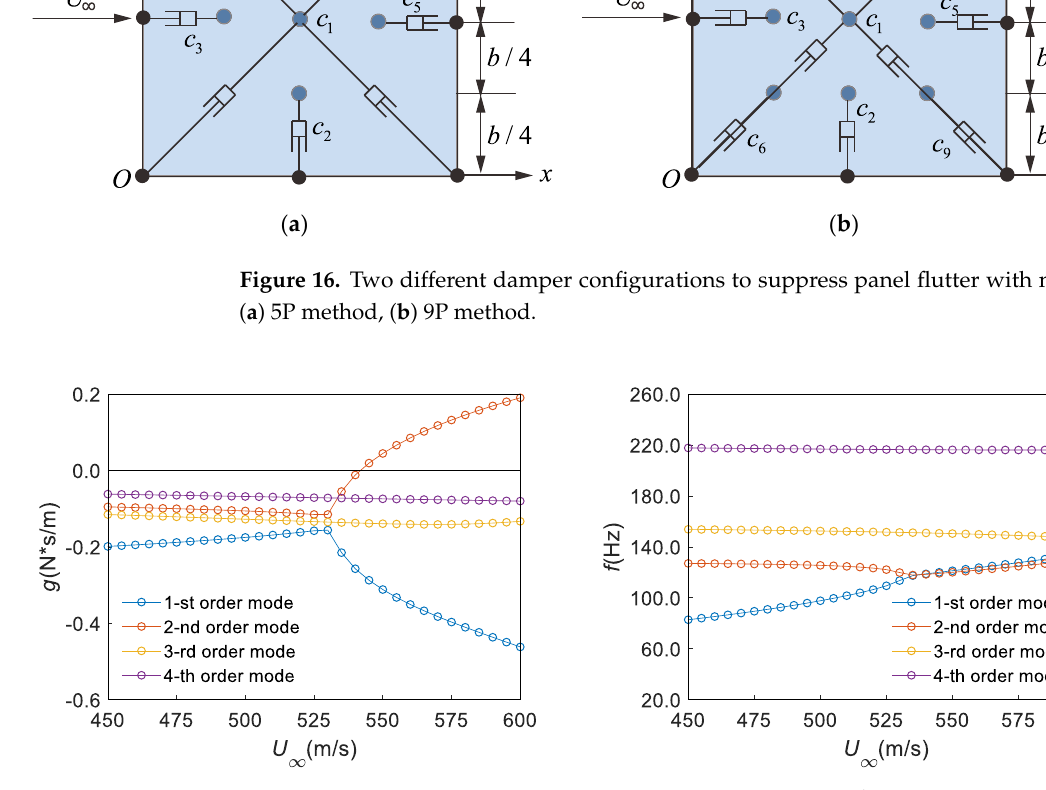
Figure 17. Results of flutter calculation for the panel with the 5P method damper configuration ( Ma ∞ = 2.0): ( a ) U − g , ( b ) U − f